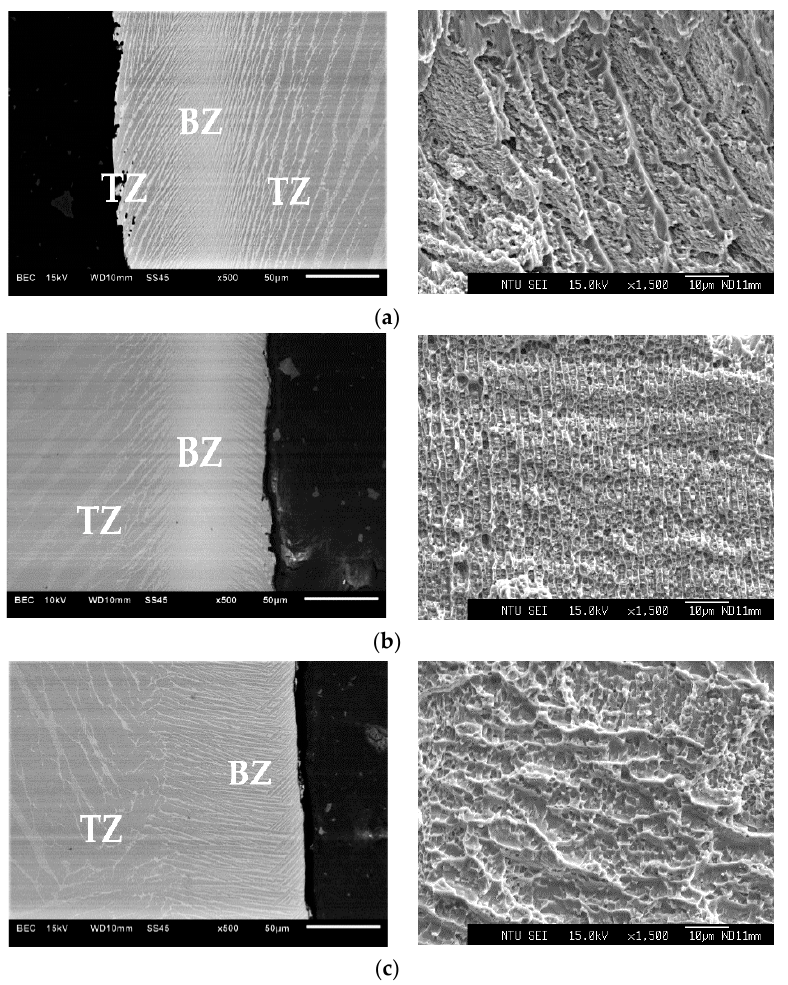
Figure 9. SEM BEI cross-sections and EPMA fractographs of joints brazed at ( a ) 1000, ( b ) 1100 and ( c ) 1200 °C for 600 s.